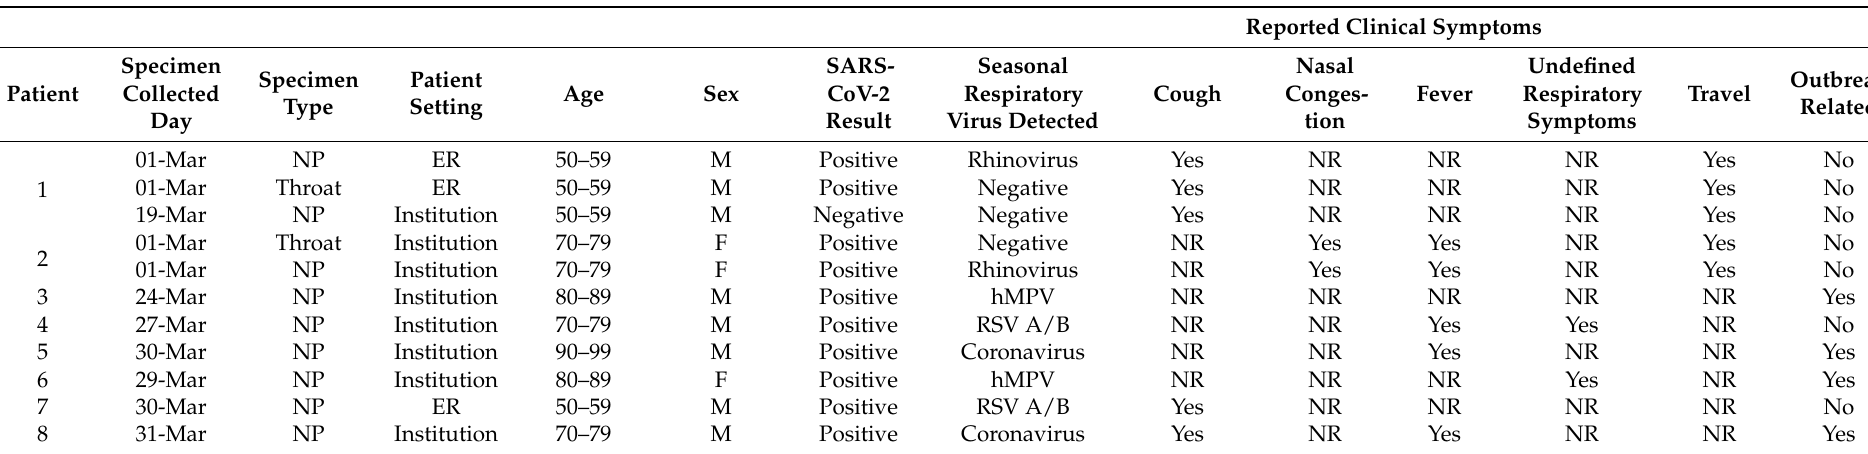
Table 4. Characteristics of individuals co-infected with SARS-CoV-2 and a seasonal respiratory virus in individuals tested by (i) SARS-CoV-2 +